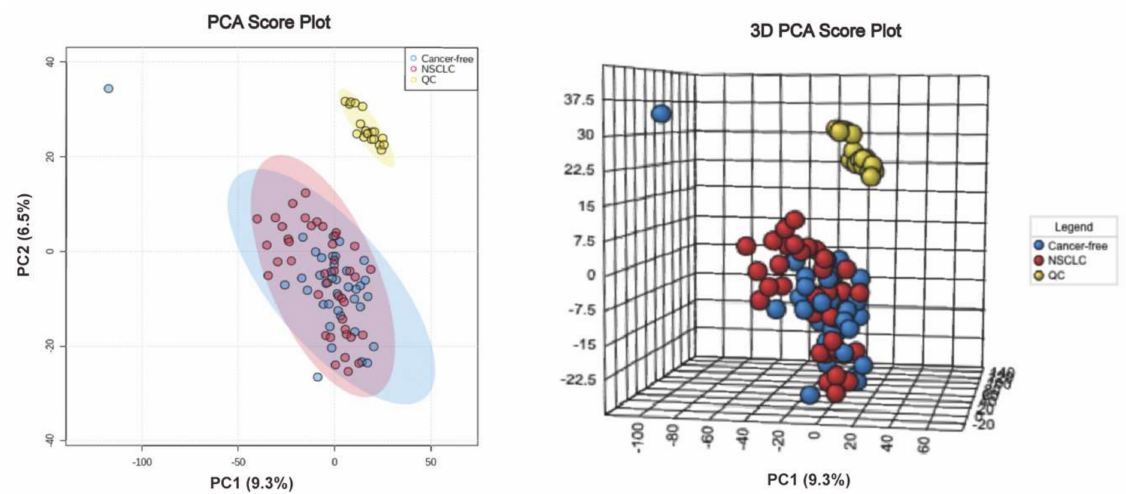
Figure A1. PCA score plot and 3D PCA score plot between NSCLC and cancer-free